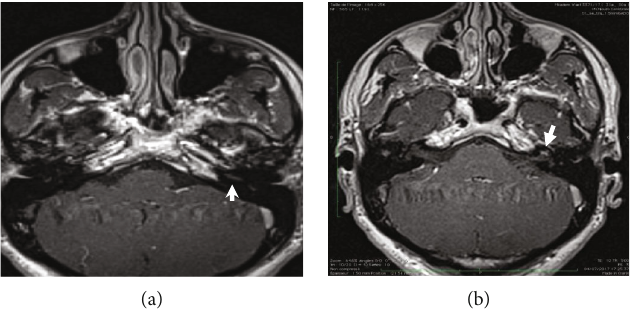
Figure 3: Magnetic resonance imaging of the temporal bone: axial postcontrast T1-weighted slices showing no enhancement after gadolinium injection in the basal (a) and the second (b) turns of the left